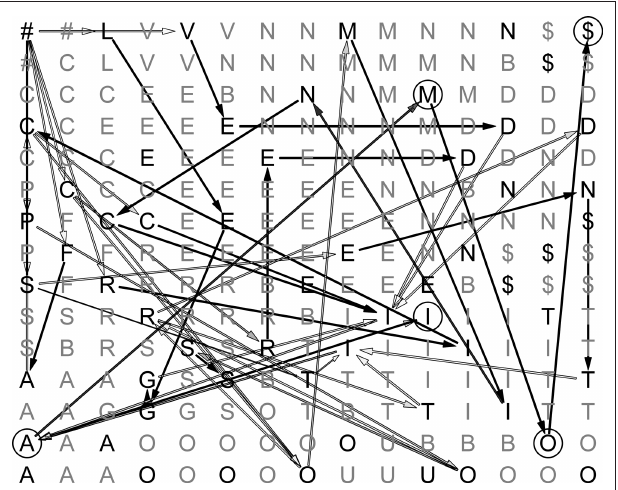
Figure 4 | Sample map during learning. Darker edges represent more probable transitions, and lighter edges represent less probable